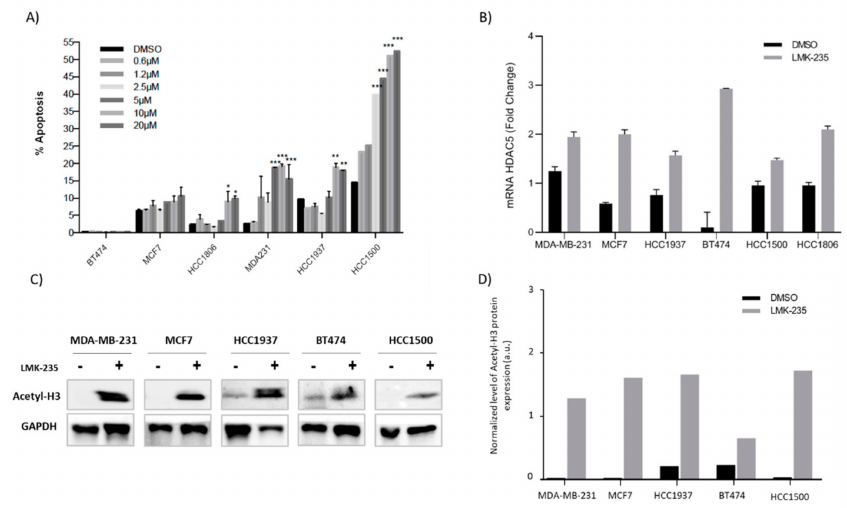
Figure 5. Percentages of apoptosis are shown after treatment with LMK-235 (0.6 to 20 µ M) or DMSO for 48 h. Apoptosis was analyzed by triplicated and SD was calculated ( A ); Expression of HDA5 in breast cancer cell lines treated with LMK-235 (20 µ M) and DMSO control ( B ); Accumulation of acetyl-histone H3 after 48 h of LMK-235 (20 µ M) treatment in breast cancer cell lines examined by western-blot. The levels of acetyl-histone H3 were determined by western blot. GAPDH was used as a loading control ( C ). Densitometry western bolt analyzed by ImageJ software ( D ). * p ≤ 0.05, ** p ≤ 0.01, *** p ≤